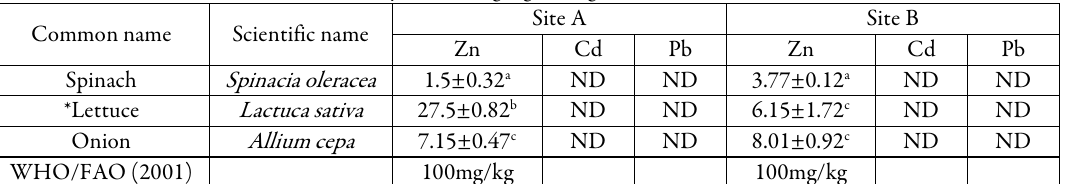
Table 3. Mean concentration of heavy metals (mg/kg) in vegetables Common name